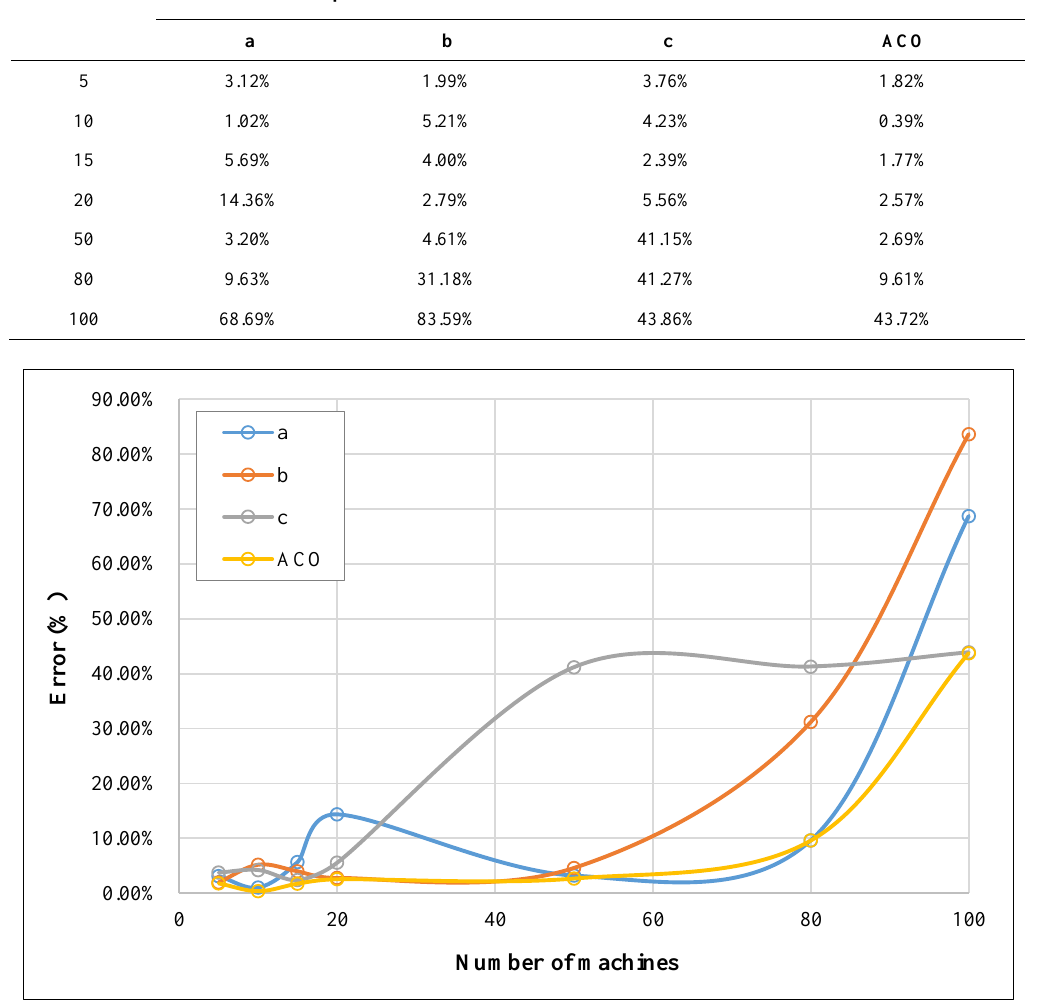
Figure 3. Error rate for mode of n=10 Table 4. A comparison of different solution methods in mode of n=20